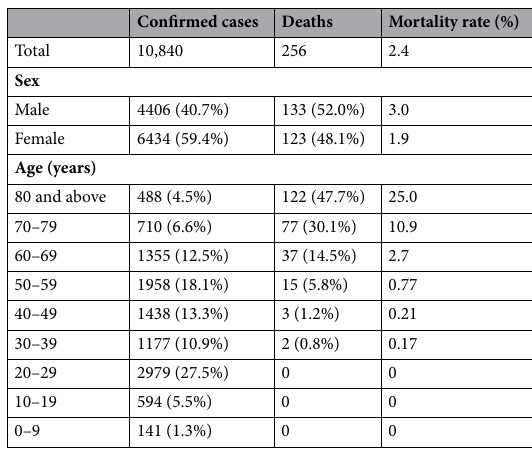
Table 1. Demographics and mortality rate of 10,840 confirmed cases of COVID-19 in South Korea by May 8,